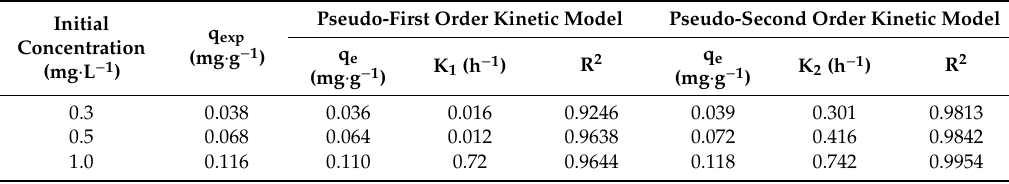
Table 5. Kinetics of phosphorus removal by RSPRC at di ff erent initial